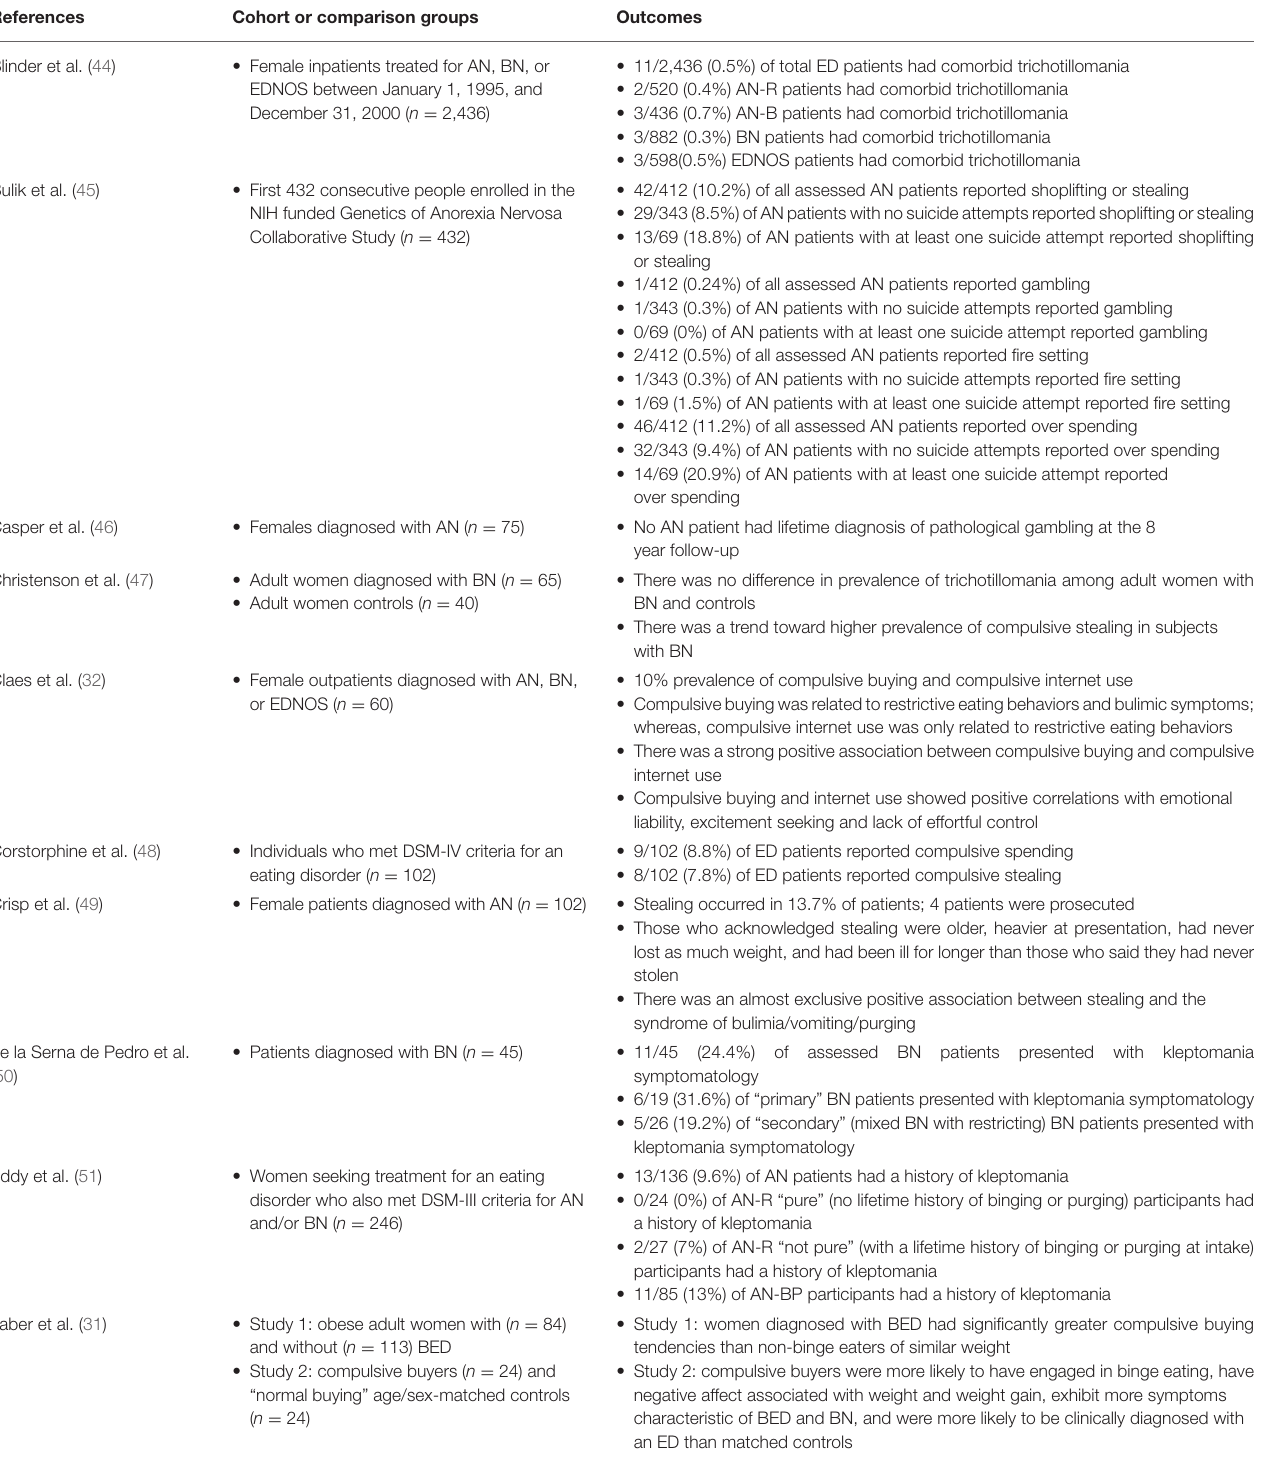
TABLE 2 | Details of eating disorders and behavioral addictions results of included studies ( N =